Question: Write a caption explaining this figure to a reader.
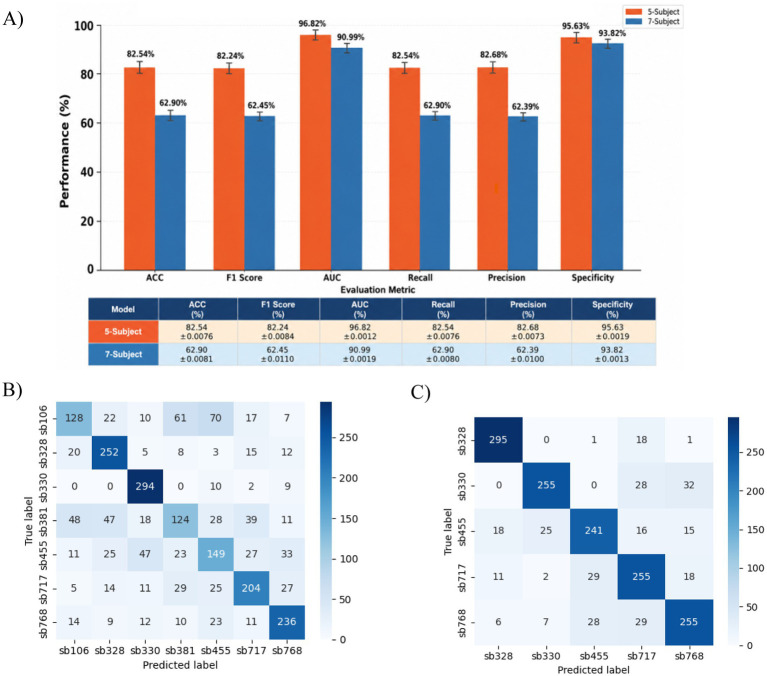
Answer: Performance evaluation and comparison of 5-subject and 7-subject experiments. (A) SVM based model performance for 5-subject and 7-subject experiment, (B) confusion matrix for 7-subject experiment, (C) confusion matrix for 5-subject experiment.